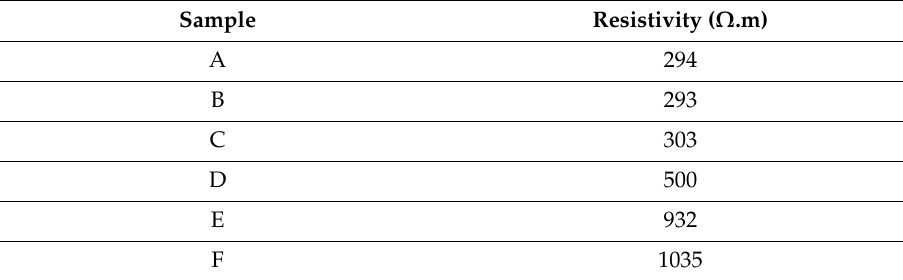
Table 7. Electrical Resistivity of Di ff erent Samples at 25 ◦